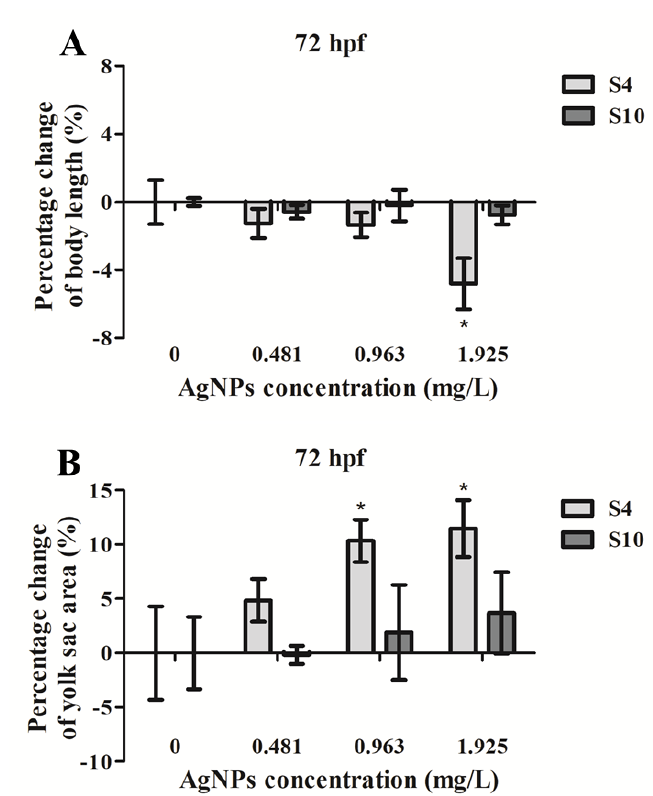
Figure 2. Representative phenotypes of zebrafish embryos upon exposure to AgNP concentration of ( B ) 1.925 mg/L, compared with the control ( A ) at 72 hpf. Scale bar = 500 μm.